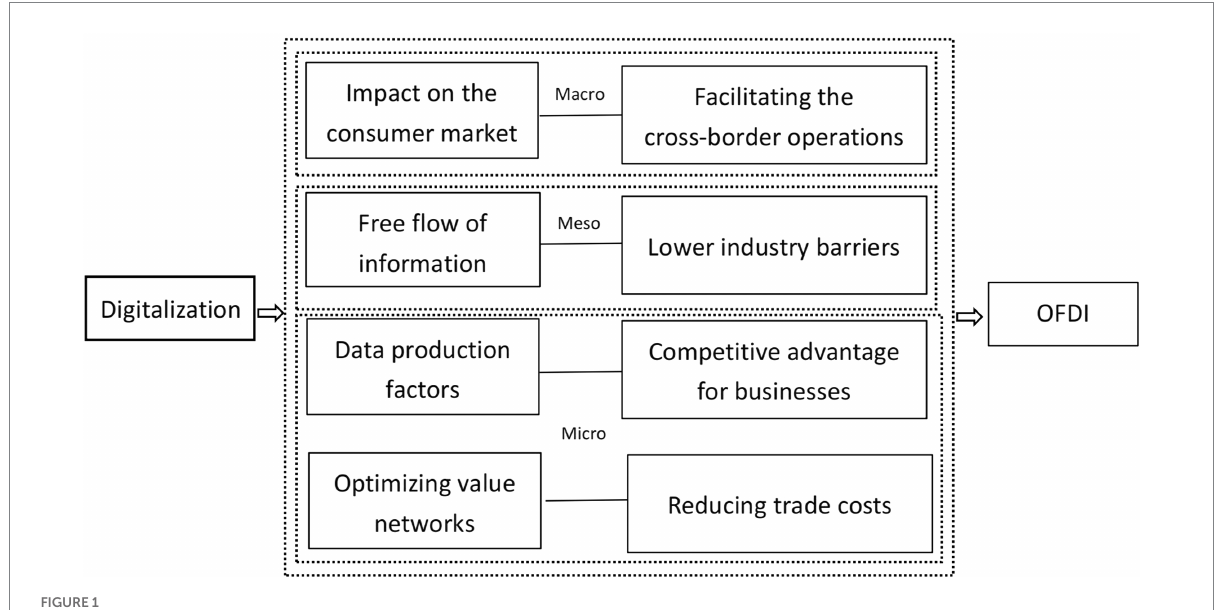
FIGURE 1 Analysis of the mechanism of digitalization on enterprise